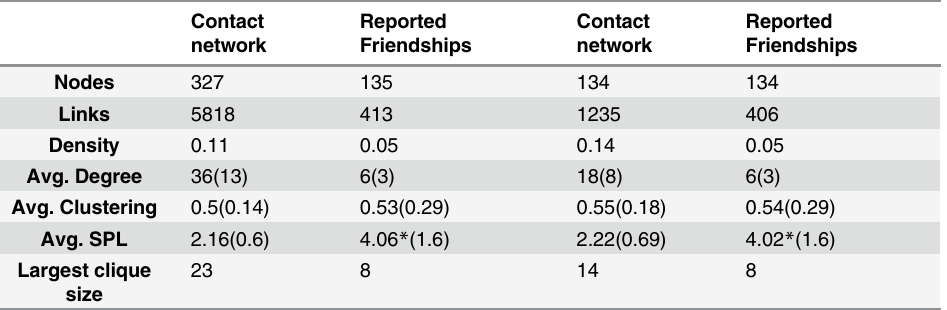
Table 5. Summary statistics for the global contact network and the network of reported friendships. All network properties for the network of friendships are computed on its symmetrized version. Values on the right part of the table are obtained after retaining only the students present in both networks.